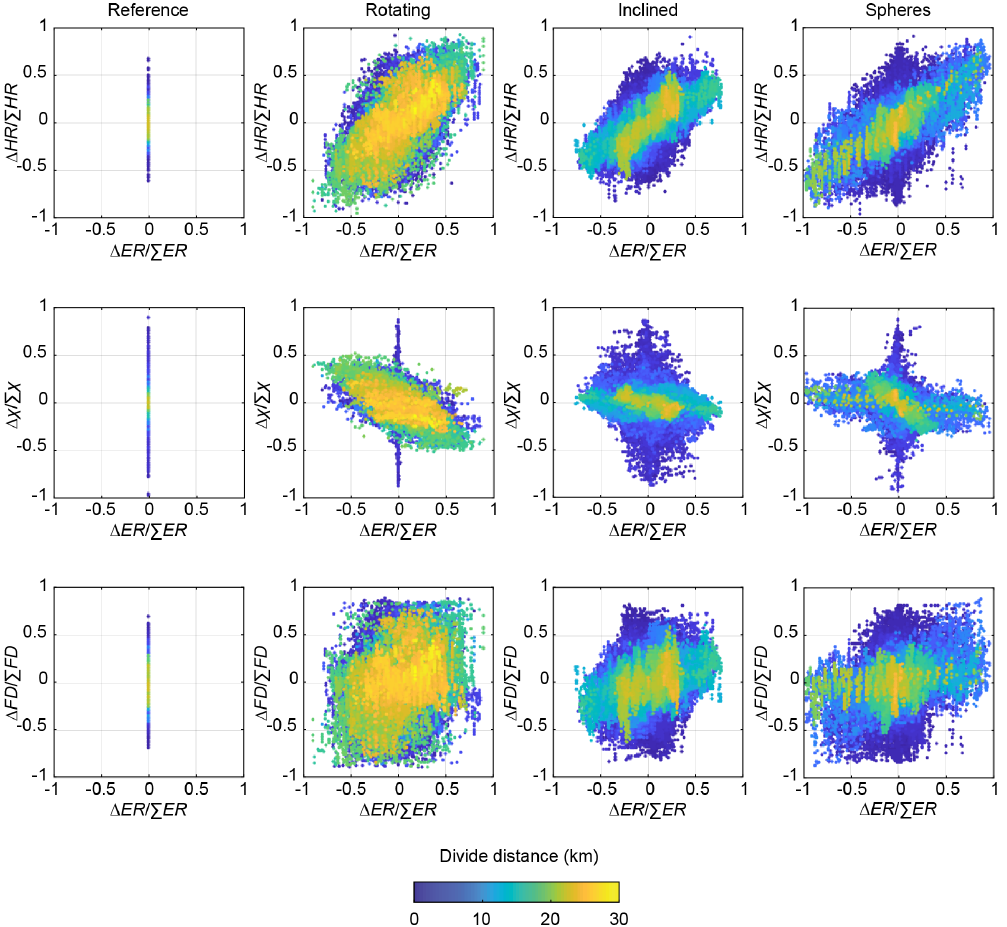
Figure 11. Relationship between across-divide differences in the topographic metrics hillslope relief (HR), chi ( χ ), and flow distance (FD), with across-divide differences in erosion rates (ERs) for all divide edges in the last 1Myr of the landscape evolution experiments Reference, Rotating, Inclined, and Spheres. Marker color denotes the divide distance ( d d ). Note that the markers are sorted by their divide distance to show the highest divide distance above data points with lower divide distance, and data points with lower divide distance occur beneath those with higher divide distance.